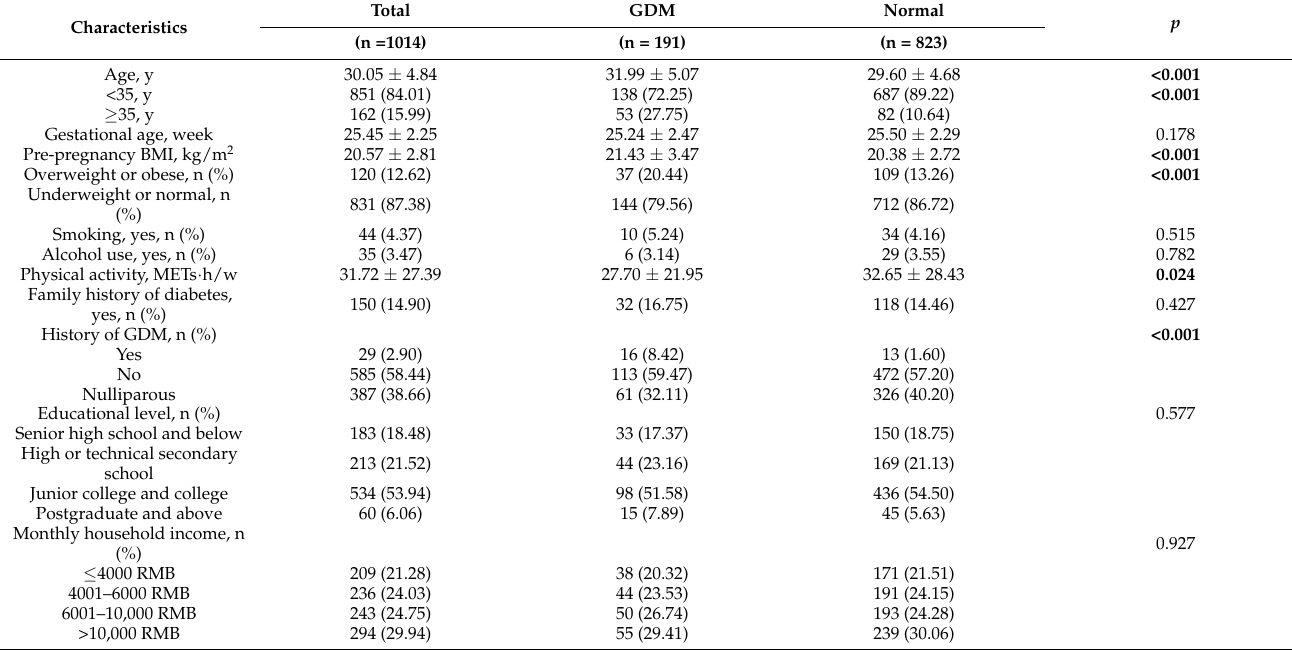
Table 1. Characteristics of pregnant women by categories of GDM.